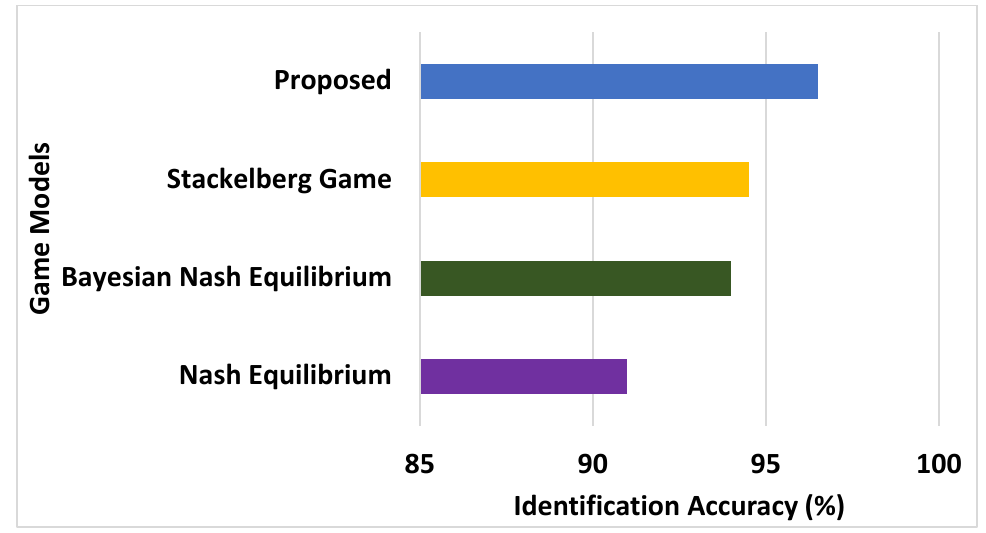
Figure 6. Comparative analysis of identification accuracy.